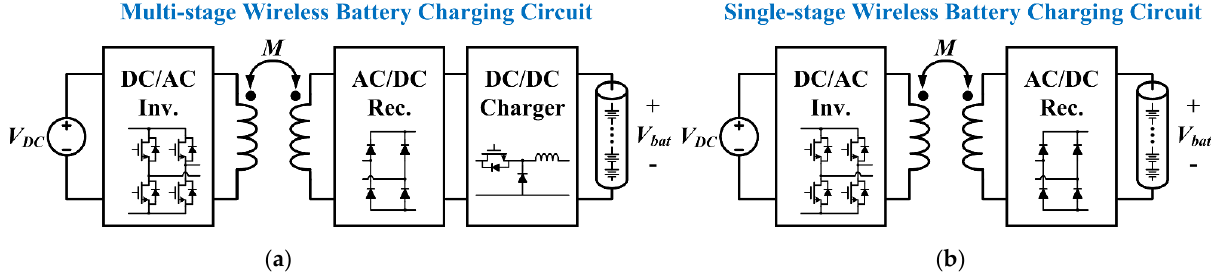
Figure 1. ( a ) Multi-stage wireless battery charging circuit; ( b ) single-stage wireless battery charging circuit.